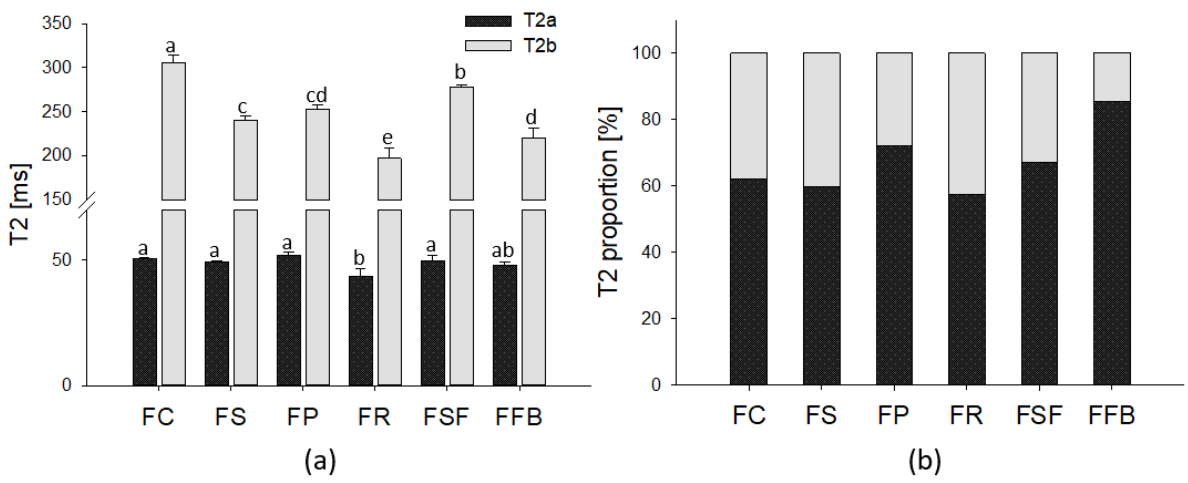
Figure 6. ( a ) The T2 center relaxation time and ( b ) relative area of the two water populations (T2a and T2b) of hybrid meat emulsions elaborated with plant proteins as partial meat substitutes. Mean values with different letters on the columns of each parameter differ from each other ( p ≤ 0.05) according to the post hoc Tukey’s test. FC: control; FS: soy; FP: pea; FR: rice; FSF: sunflower; FFB: fava bean.